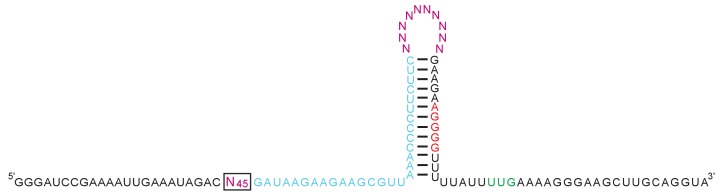
In vitro selection pool design for a photoriboswitch.An RNA pool was derived from B. subtilis mswA SAM-I riboswitch by replacing its ligand-binding domain with a 45-nucleotide random sequence (pink, boxed), partially randomizing (at a 15% level) its anti-terminator hairpin and the 5' half of the terminator hairpin (light blue), replacing the terminator-helix tetraloop sequence (UUAU) with a random decamer (pink), and retaining the 3' half of the terminator hairpin and its translation initiation sequences (red – Shine-Dalgarno sequence; green – start codon). The pool’s constant regions are shown in black.